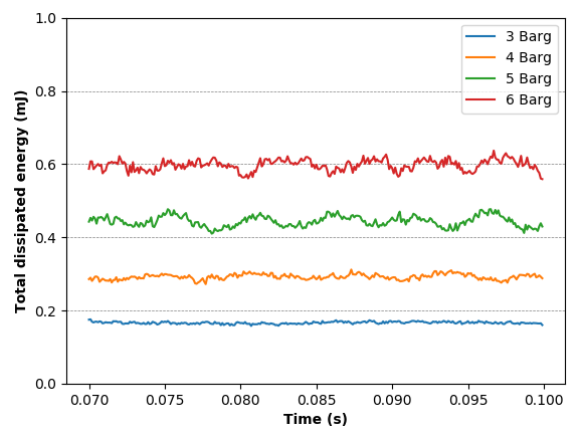
Fig 4: Energy dissipated through particle collisions for the 1.2 g loading